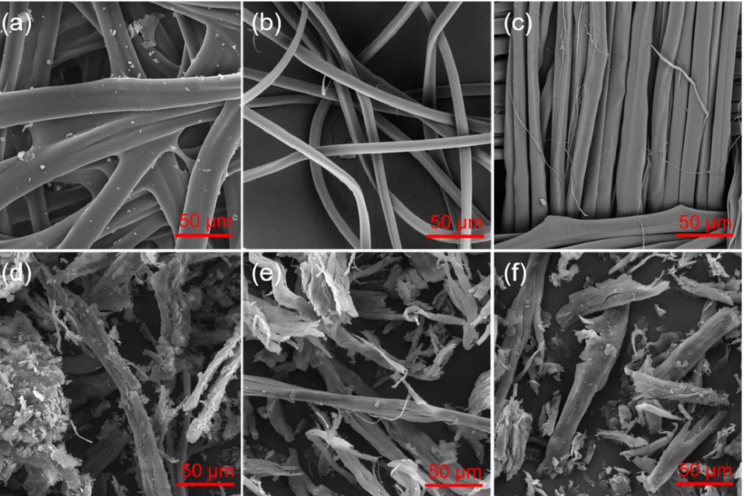
Figure 3. SEM images of ( a ) raw silk cocoons, ( b ) degummed silk cocoons, ( c ) silk fabric, and silk powders from ( d ) raw cocoons, ( e ) degummed cocoons, and ( f ) silk